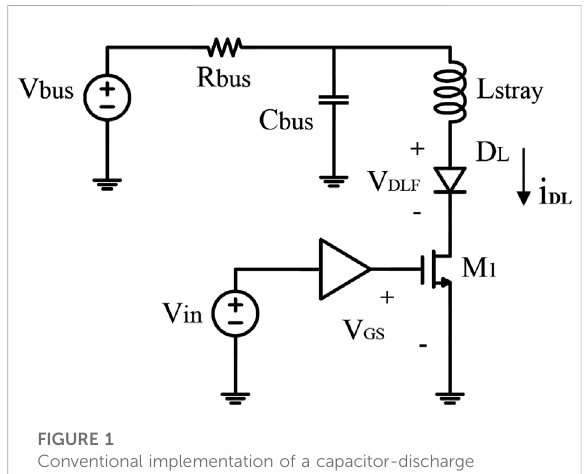
Conventional implementation of a capacitor-discharge resonant